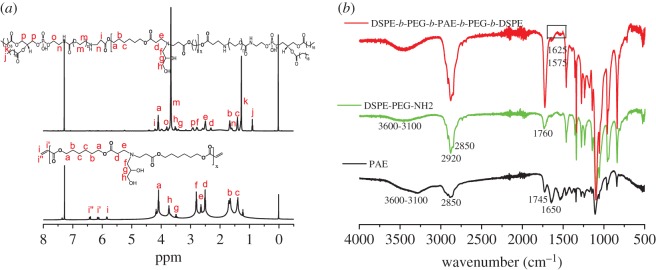
1H-NMR (a) spectra of diacrylate-terminated polymer PAE and copolymer DSPE-b-PEG-b-PAE-b-PEG-b-DSPE in d-CDCl3, and the according FT-IR (b) spectra.